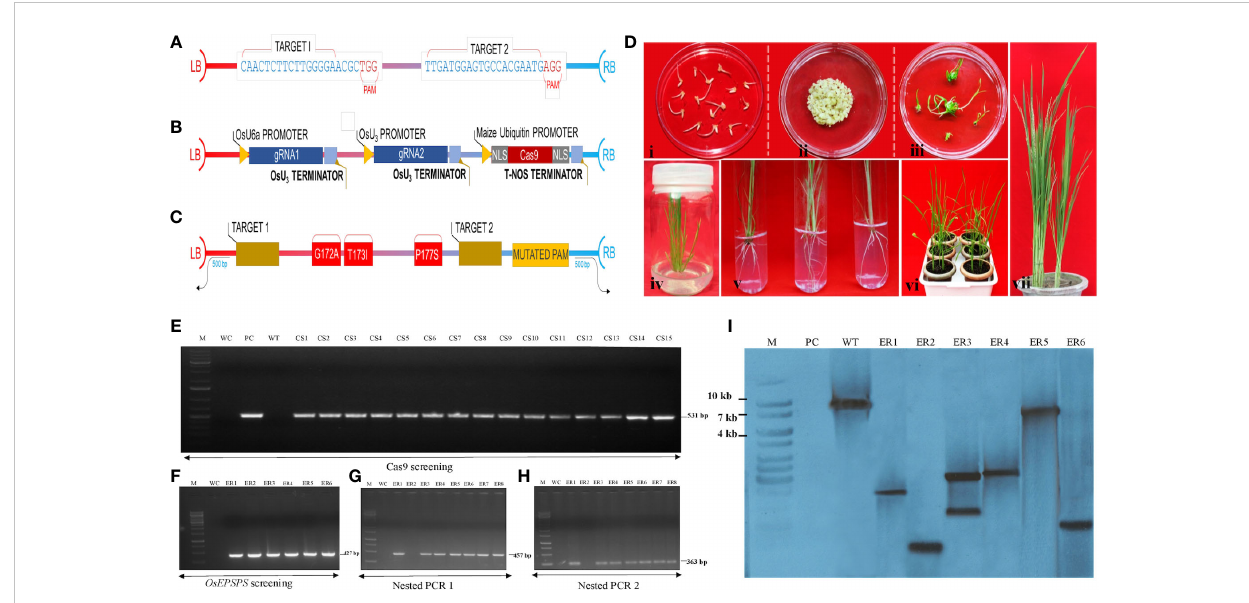
FIGURE 2 Construction of CRISPR-Cas9 – based plant expression cassette and molecular analysis of edited rice plants. (A) The structures of pCAMBIA1300-based NICTK-1_pCRISPR-Cas9 binary vector. Nuclear localization sequence (NLS), essential sequences, and restriction sites required for the cloning. (B) Schematic representation of OsEPSPS- sgRNA expression cassettes. (C) Schematic representation of OsEPSPS -HDR template with desired mutation sites. (D) Different stages of edited plant development following tissue culture, where (i) embryogenic callus formation in callus induction media; (ii) biolistic transformation; (iii) shoot initiation in shooting media; (iv) regeneration of well-developed shoot; (v) root initiation; (vi) acclimatization of plant in green house; and (vii) developed regenerated plantlets. (E) PCR con fi rmation of putative edited plants using Cas9 gene speci fi c internal forward and reverse primers. The ampli fi ed lanes S1 – S15 denote putative transformed rice samples, where M, 1-kb DNA ladder; WC, water control; P, positive control (plasmid DNA template); WT, wild-type plants. (F – H) PCR con fi rmation of edited plants using EPSPS (gene speci fi c) internal forward and reverse primers following by nested PCR1 and nested PCR2. The ampli fi ed lanes S1 – S6 denote edited rice samples, where M, 1-kb DNA ladder; WC, water control. (I) Southern blot analysis of edited rice lines. Southern blot signals (S1 – S6) con fi rm the presence Cas9 in edited lines, where M, marker; PC, positive control (Cas9); WT, wild-type